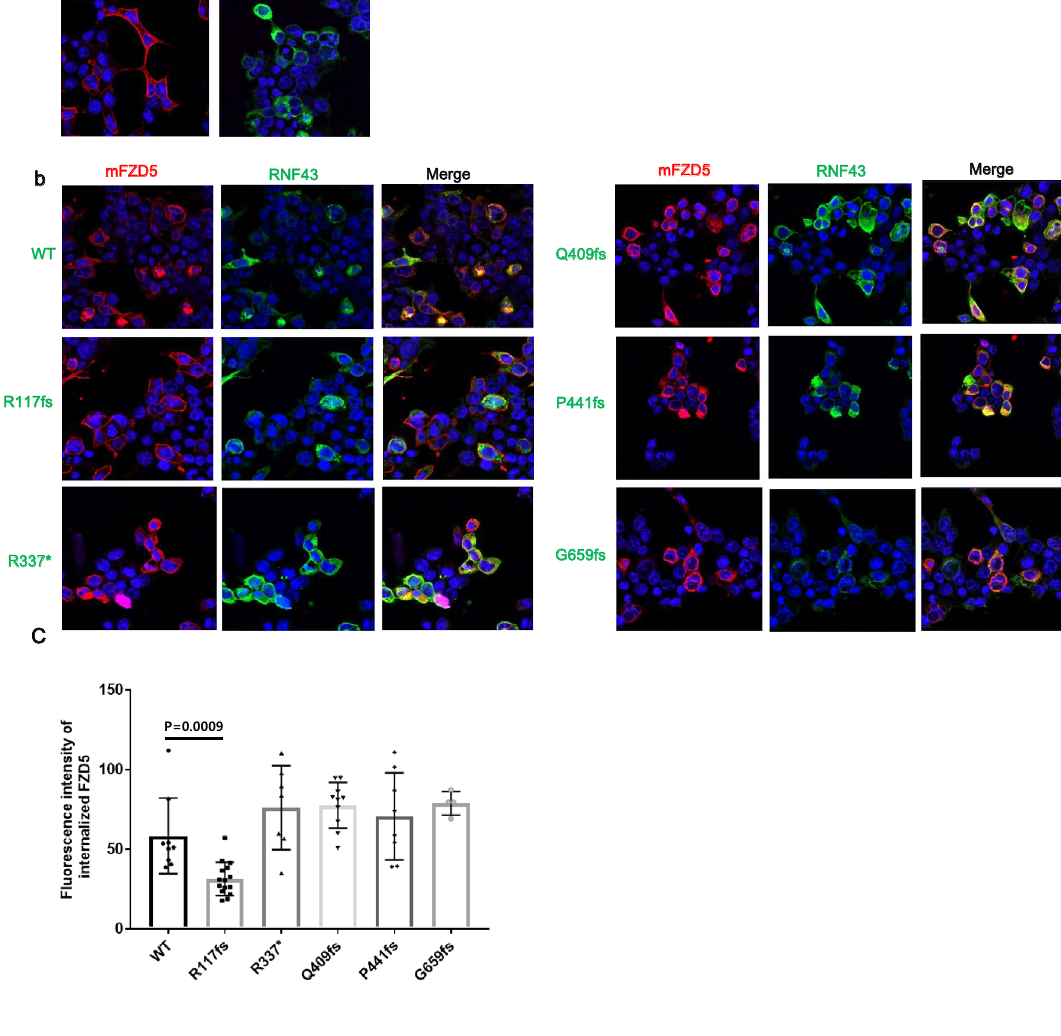
Figure 4. R117fs mutant does not downregulate cell surface expression of FZD. ( a ) Subcellular localization of Myc-tagged mFZD5 and FLAG-tagged RNF43 (WT). ( b ) FLAG-tagged RNF43 and its mutants were co-expressed with Myc-tagged mFZD5 in HEK293T cells. Subcellular localization of RNF43 and FZD5 was observed by confocal microscopy. ( c ) Fluorescence intensity of internalized FZD5 was quantified using Image J. Error bars represent ± SD. P value was determined by Student’s t